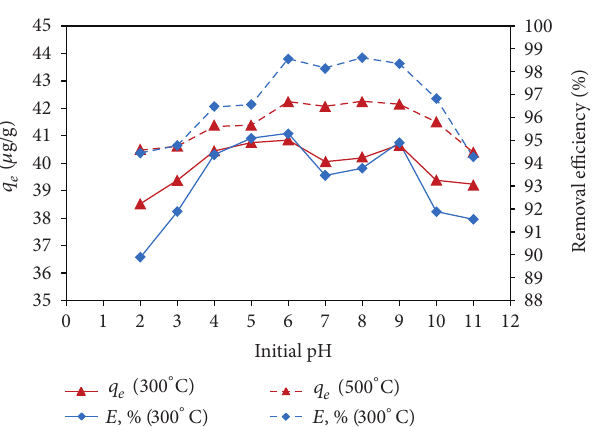
F 3: Effect of adsorbent dose on As(V) removal (the initial As(V) concentration , and contact time of